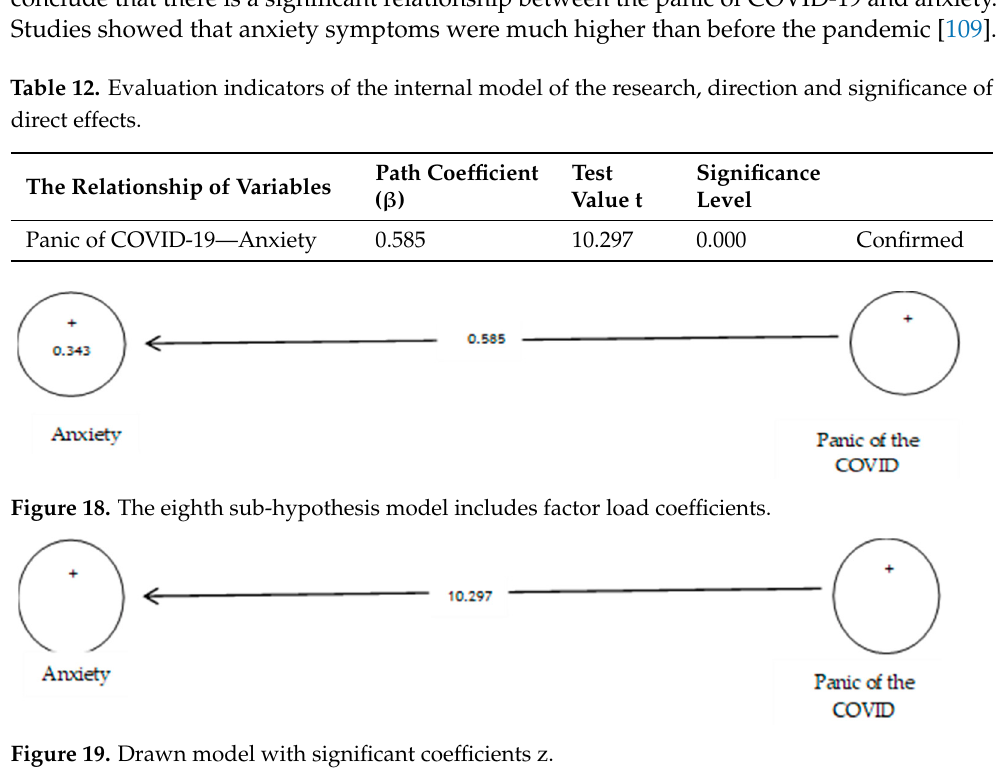
Figure 19. Drawn model with significant coefficients z. Table 12. Evaluation indicators of the internal model of the research, direction and significance of direct effects.